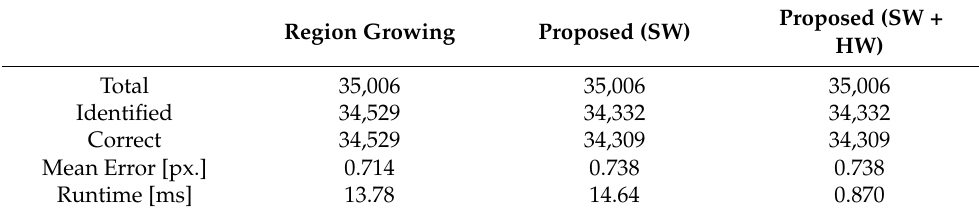
Table 5. Comparison of centroid algorithms, with FOV =